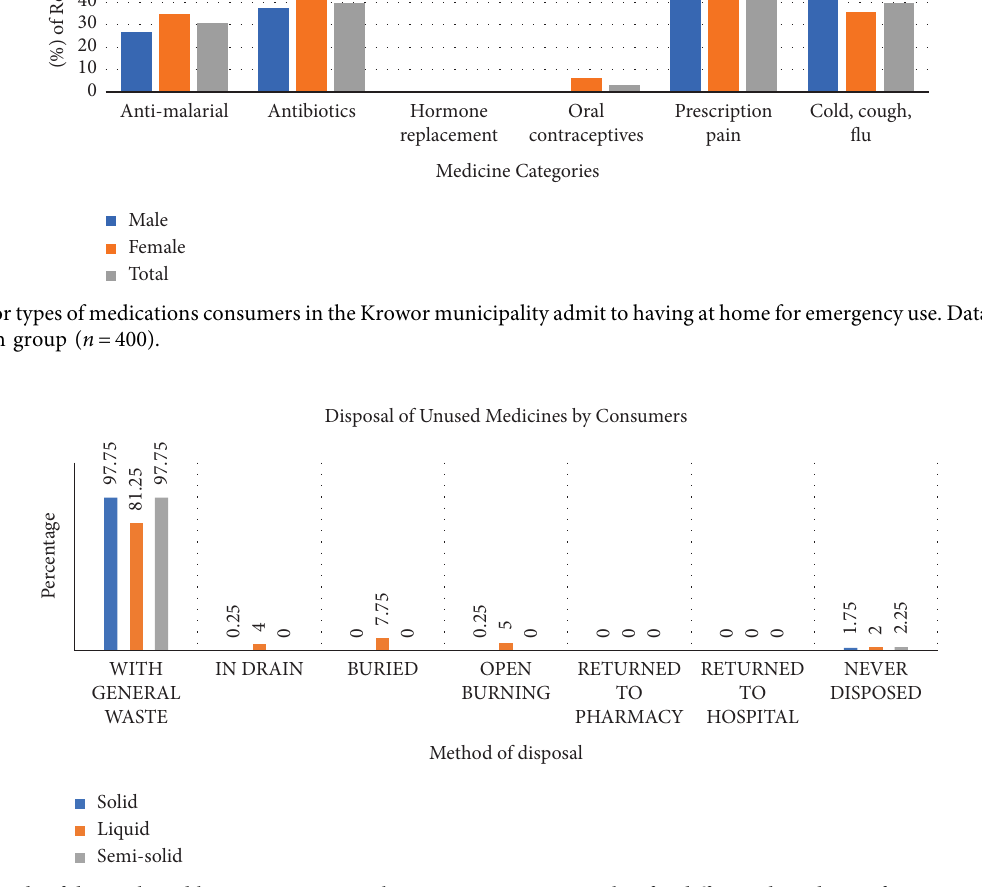
Figure 4: Methods of disposal used by community members in Krowor municipality for diferent drug dosage forms. Data represent the means for each group ( n �